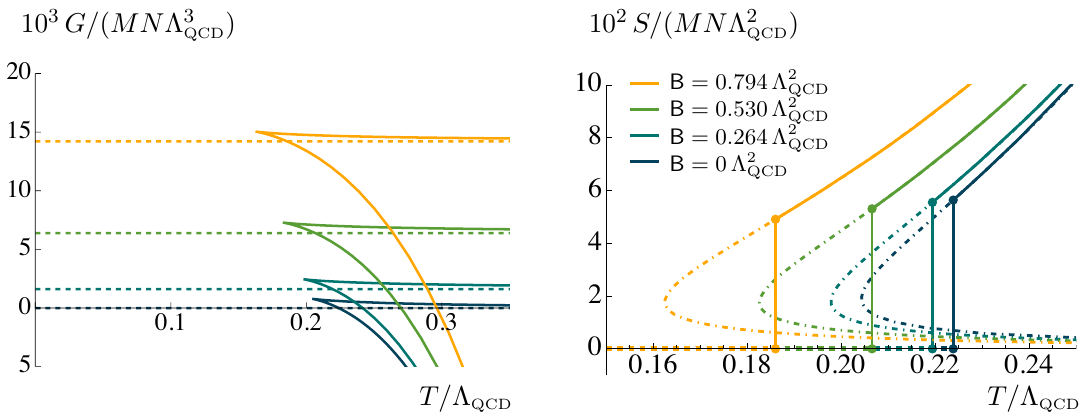
Figure 7. Left : free-energy densities, as a function of temperature, for the magnetized plasma (solid curves) and magnetized confining phase (dashed lines) for different choices of magnetic field in the range B ∈ [0 , B ) , with B increasing from bottom to top. The phase with the lowest free- triple energy density is preferred, so we encounter a confinement/deconfinement phase transition when the two curves cross. Right : entropy density, as a function of temperature, for the same solutions. The dot-dashed curves indicate thermodynamically-disfavoured states of the system. The discontinuity at the phase transition indicates that it is first